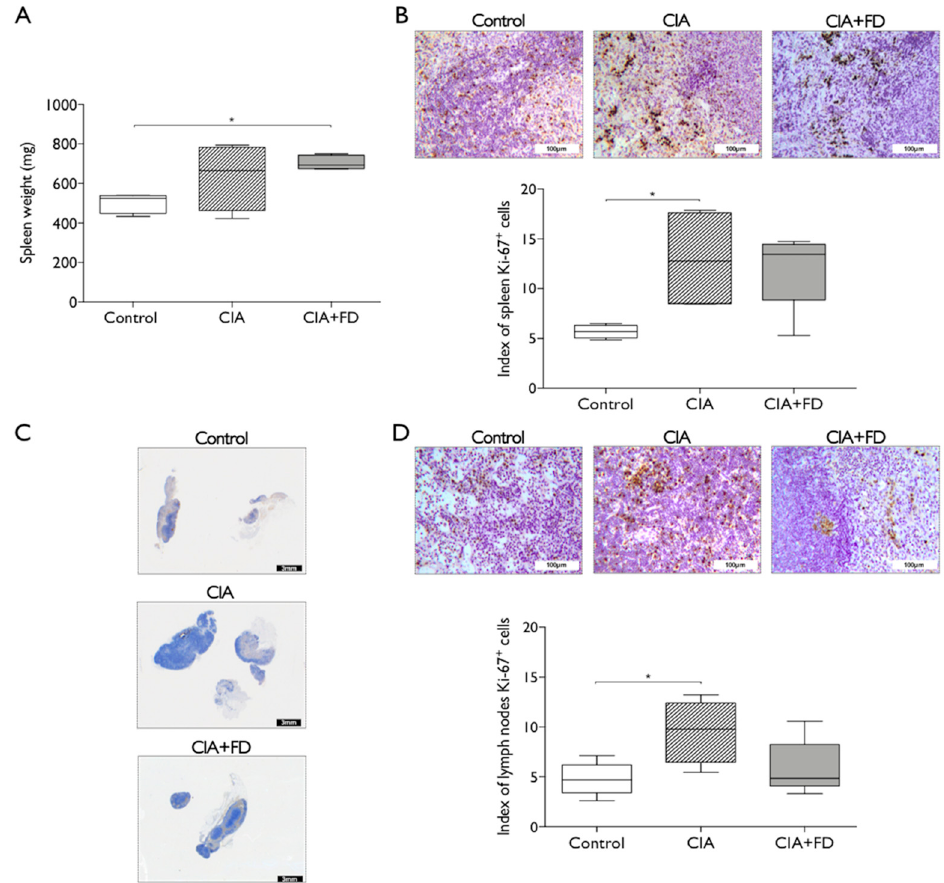
Figure 2. Arthritis induction and the combination with femoral defect promotes alterations in rat secondary lymphoid organs. ( A ) Spleen weight from control, CIA, and CIA + FD animals. ( B ) Representative spleen paraffin-section showing immunohistochemistry (IHQ) staining for the proliferation marker Ki-67, and quantitative staining evaluation across different sections of all animals. ( C ) Draining lymph nodes general view of histological analysis. ( D ) Higher magnification showing Ki-67 IHQ staining, and quantitative staining evaluation across different sections of all animals. Box plots represent min-to-max distribution of n = 4 to 5 animals per group. * p < 0.05 determined by Mann–Whitney test. Scale bar: 3 mm (black), 100 µm (white).